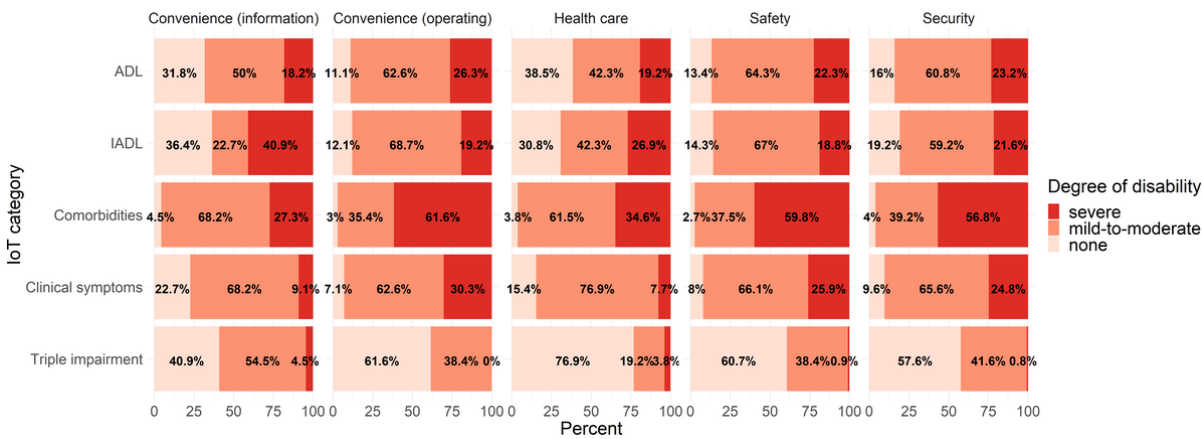
Figure 1. The total number of Internet of Things (IoT) needs by category, as a function of underlying conditions in older adults. ADL: activities of daily living; IADL: instrumental activities of daily living; Triple impairment: hearing, vision, and speech impairments.